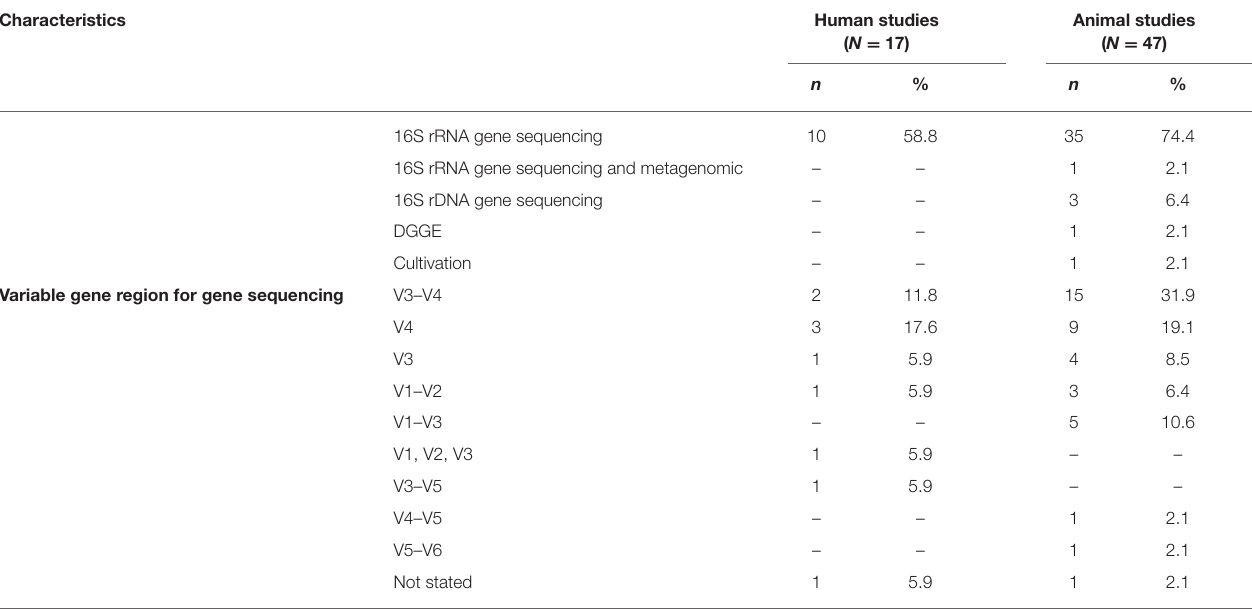
Frontiers in Endocrinology |